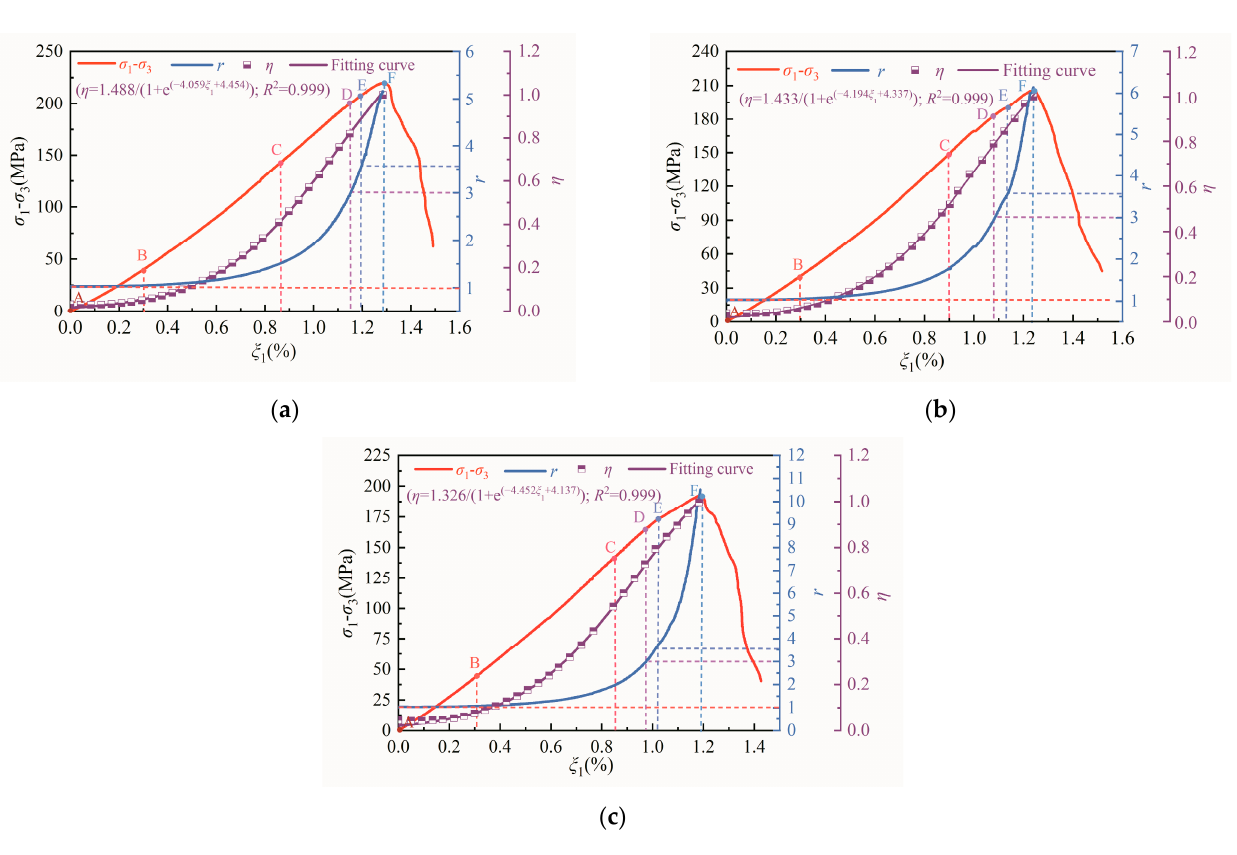
Figure 7. Chaotic mechanical phenomena of diorite strain energy accumulation under different unloading confining-pressure rates: ( a ) 0.008 MPa·s − 1 , ( b ) 0.016 MPa·s − 1 , and ( c ) 0.032 MPa·s − 1 .